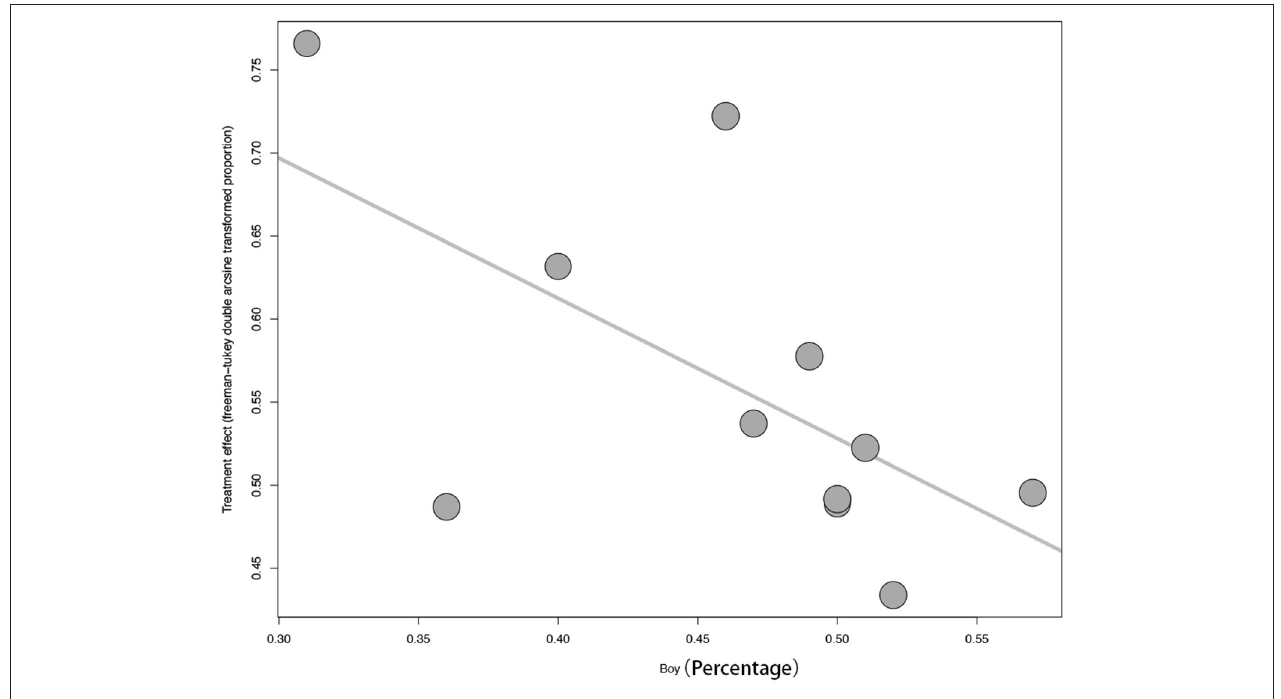
FIGURE 5 | The meta-regression analysis by “sex.”